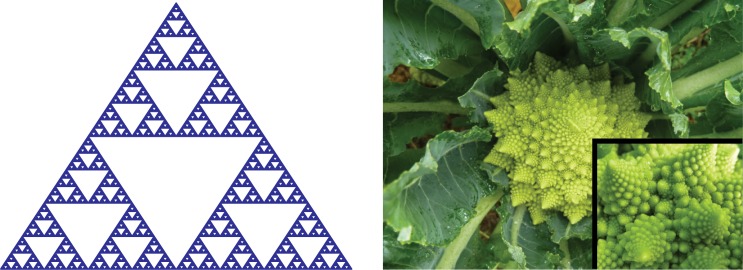
Illustration of fractal self-similarity.(a) A Sierpinski triangle is an example of a pure fractal. A small portion of the triangle looks exactly like the whole triangle. (b) Self-similarity holds across a limited range of spatial scales for a natural object such as this Romanesco Broccoli (Photos courtesy of Live Earth Farm).